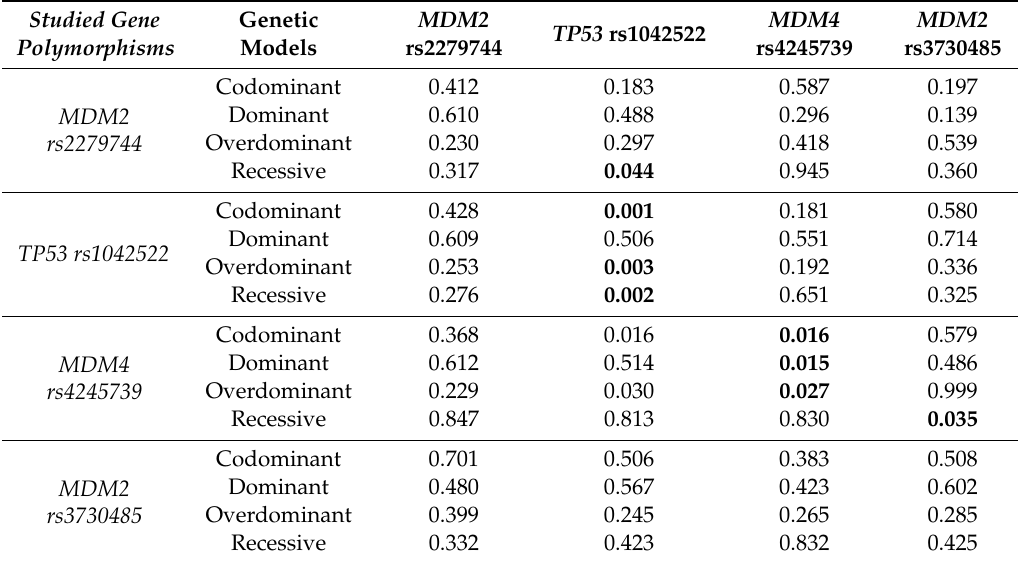
Table 2. Epistatic pairwise interactions between single nucleotide polymorphisms (SNPs) in odds of acute myeloid leukemia (AML).